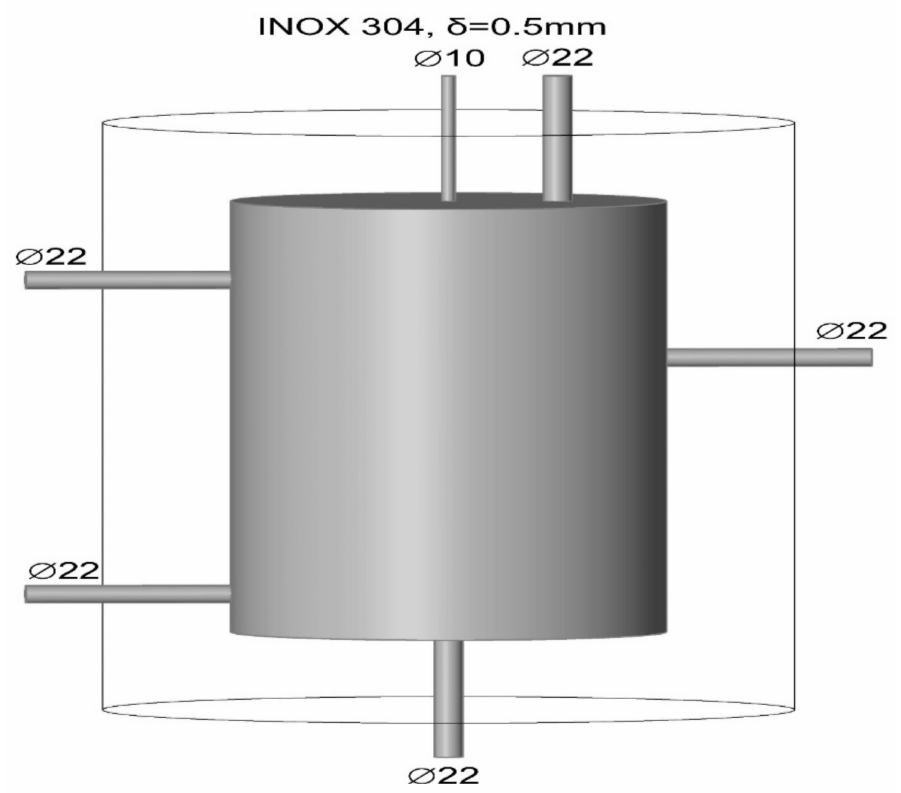
Figure 3. Design diagram of thermal storage